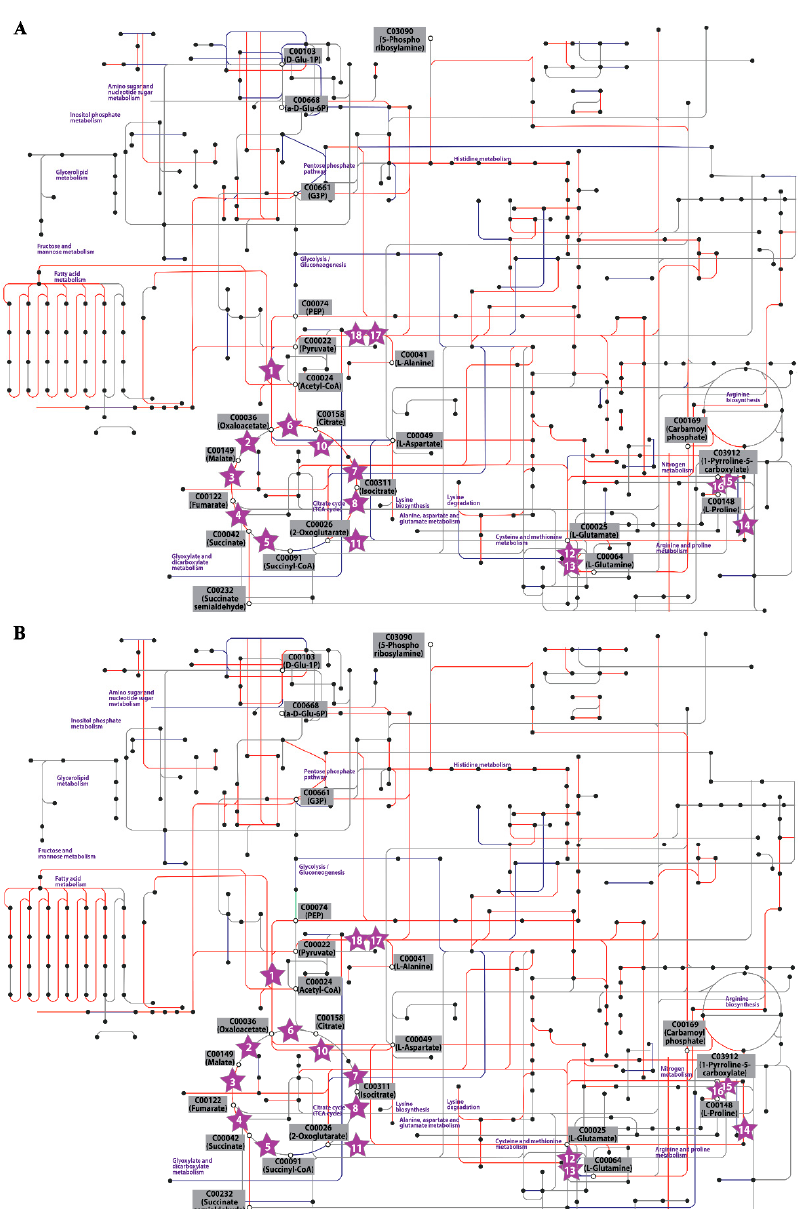
Figure 2. Central metabolic pathway mapping of the results obtained from the comparison of simulated metabolic flux when the cells were grown at ( A ) low temperature (22 °C) and ( B ) high temperature (40 °C), in comparison to that of the control (35 °C), on the template of KEGG -map01100, https: // www.kegg.jp / kegg / pathway.html#global, by using the KEGG Mapper tool. The key enzymes (star-shaped nodes) are annotated with numbers, which are in the list of Figure 3. Major metabolites (black-bordered white circles) are labeled in gray boxes, while the pathway names are labeled in violet. The blue, red and light green lines represent upregulated, downregulated and unchanged or insignificantly changed fluxes. The gray line represents the reaction with a simulated flux level of ≤